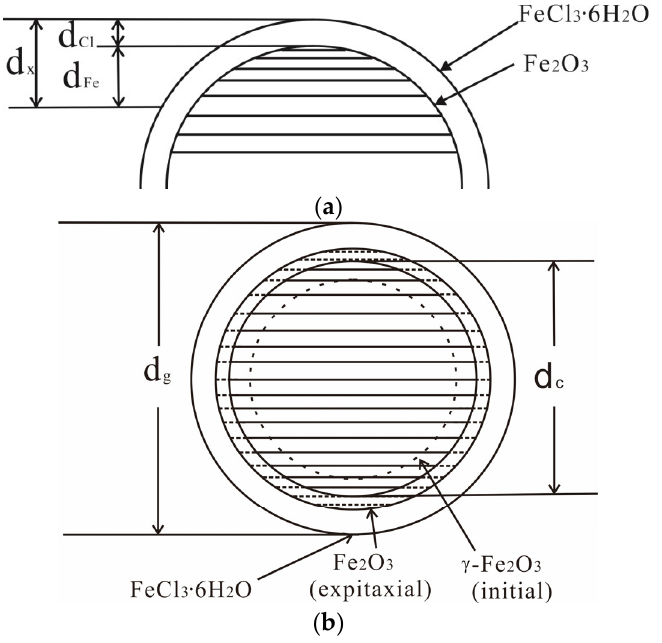
Figure 6. Schematic diagram of the XPS measurement’s region, d x , which is the depth detected by XPS ( a ). Schematic model of nanoparticle structure in samples (3) and (5) ( b ).